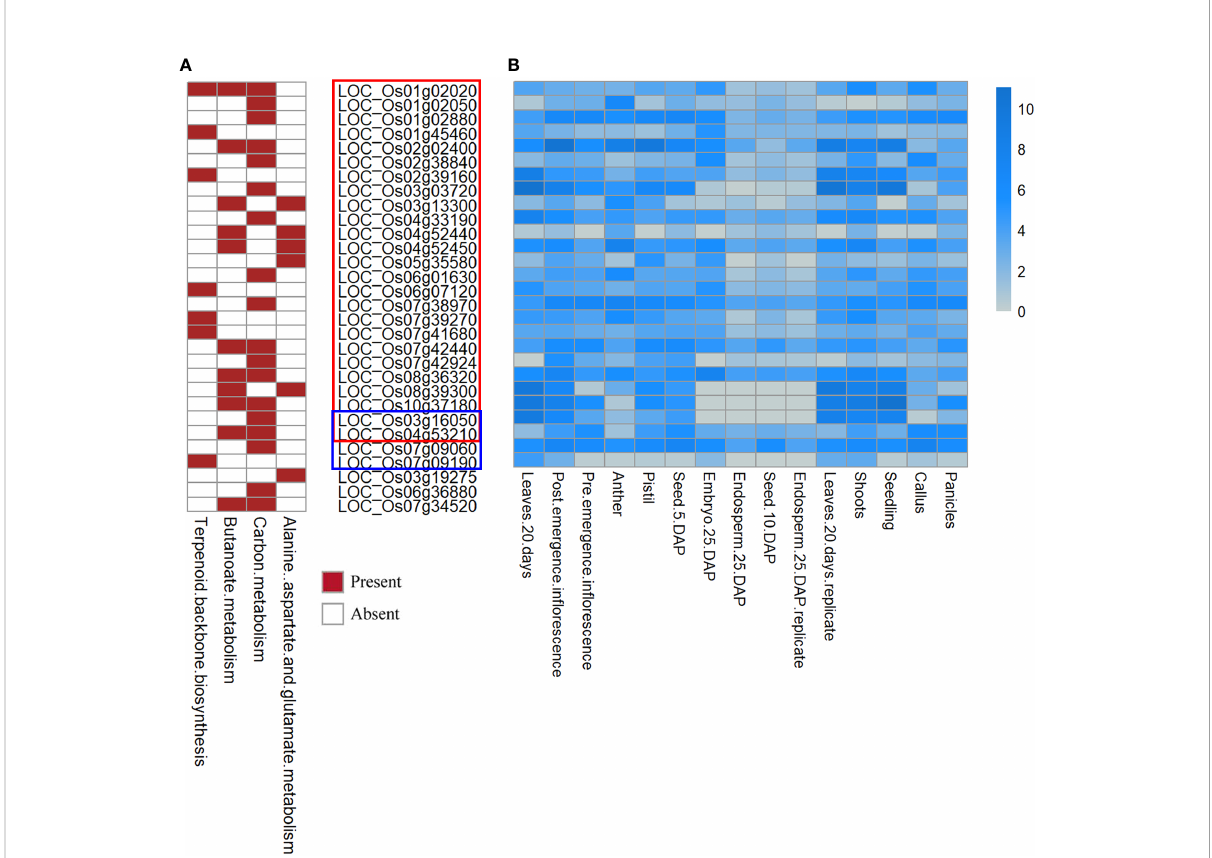
FIGURE 3 Heatmap of the functional enrichment analysis and tissue-speci fi c expression analysis. (A) Heatmap of the functional enrichment analysis for the candidate genes. (B) Heatmap of FPKM expression for the part of candidate genes. The y-axis is log2(FPKM+1). Candidate genes in the red box correspond to QTNs. Blue box: QEIs for fl owering time, remaining: candidate genes not expressed in speci fi c